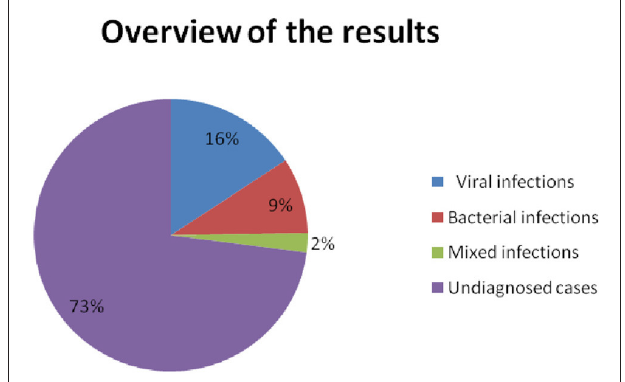
FIGURE 1 | The overview of results that detected 79 viral (69 single − 10 co-infections) and 49 bacterial (39 single 10 co-infections) and 319 undiagnosed